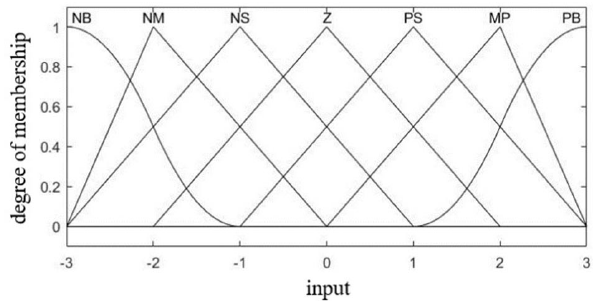
Figure 11. Membership function of